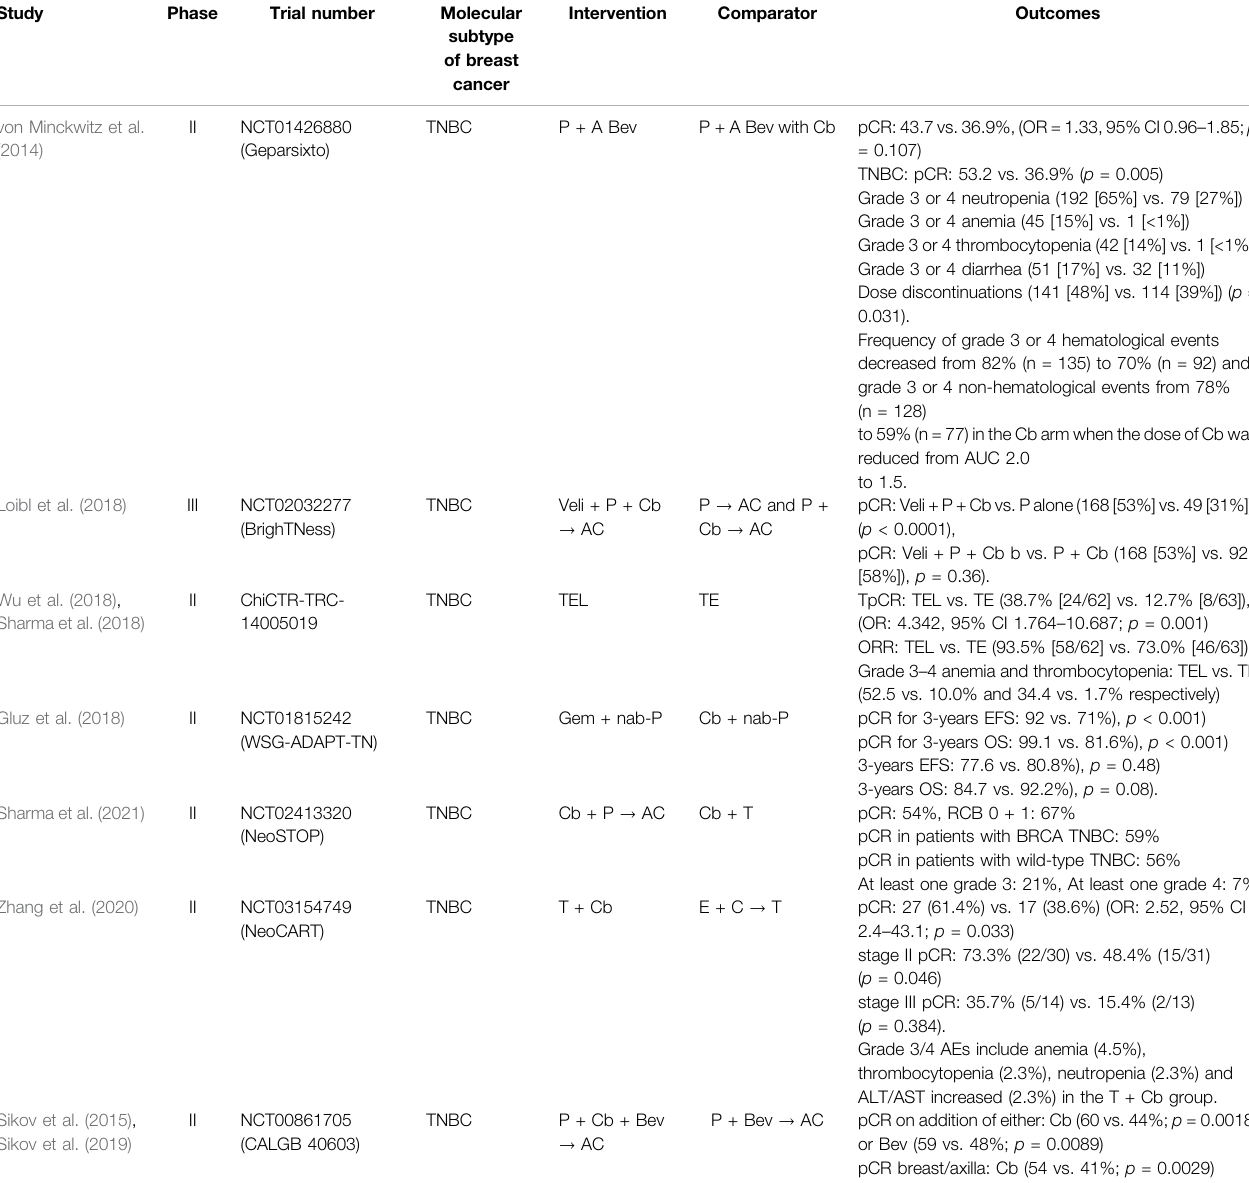
TABLE 1 | Summary of neoadjuvant studies with Pt derivatives and taxane